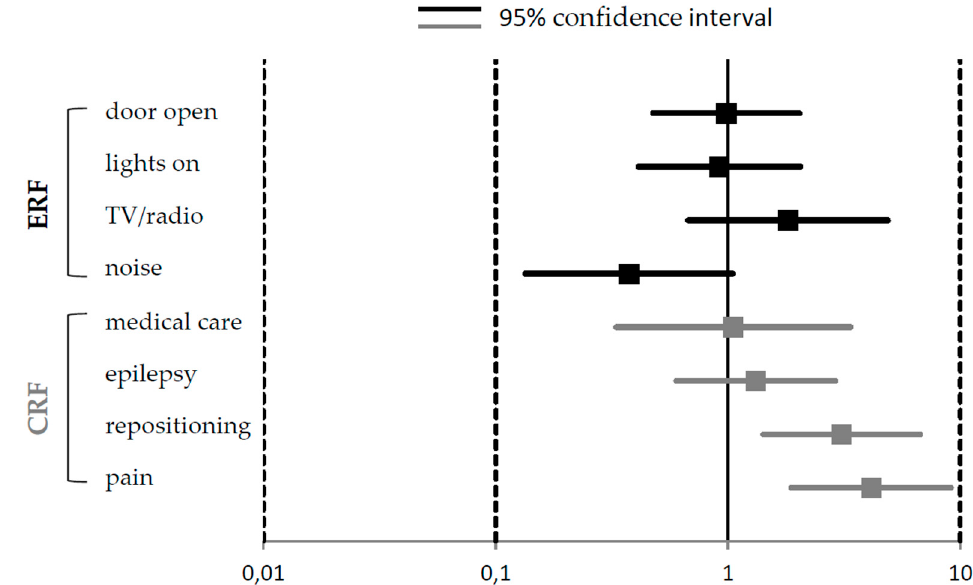
Figure 2. Odds Ratio (OR; with 95% confidence interval) of multiple logistic regression between individual CRF and ERF and the global sleep rating.